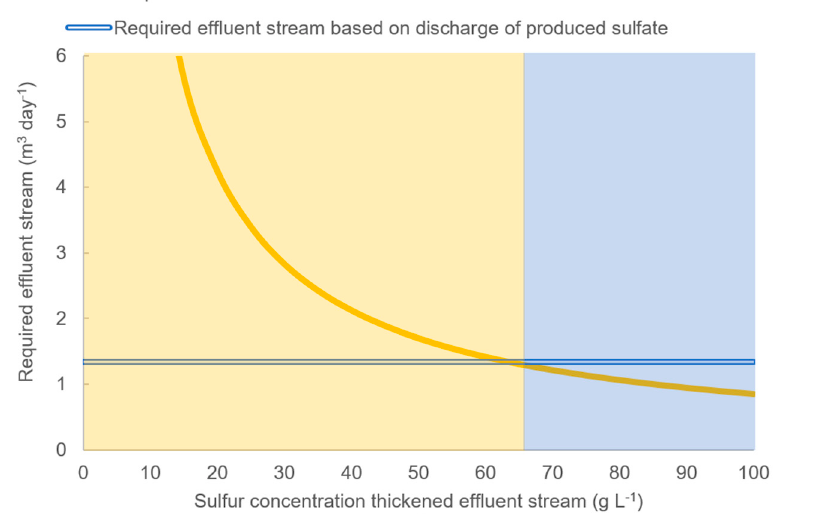
Figure 3. The relationship between sulfur concentration in the thickened effluent stream and the required effluent stream of a typical industrial BD facility. Only if the sulfur concentration in the thickened effluent stream is above 65 g L − 1 , the required effluent stream will be based on discharge of produced sulfate (blue area, right). Below this “break-even point”, the required effluent stream is solely dependent on sulfur concentration in the thickened effluent stream (yellow area, left).